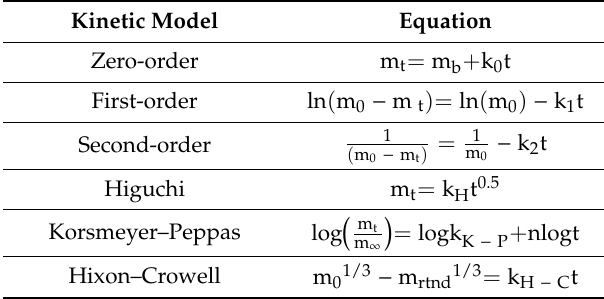
Table 7. Kinetic equations used in the drug release